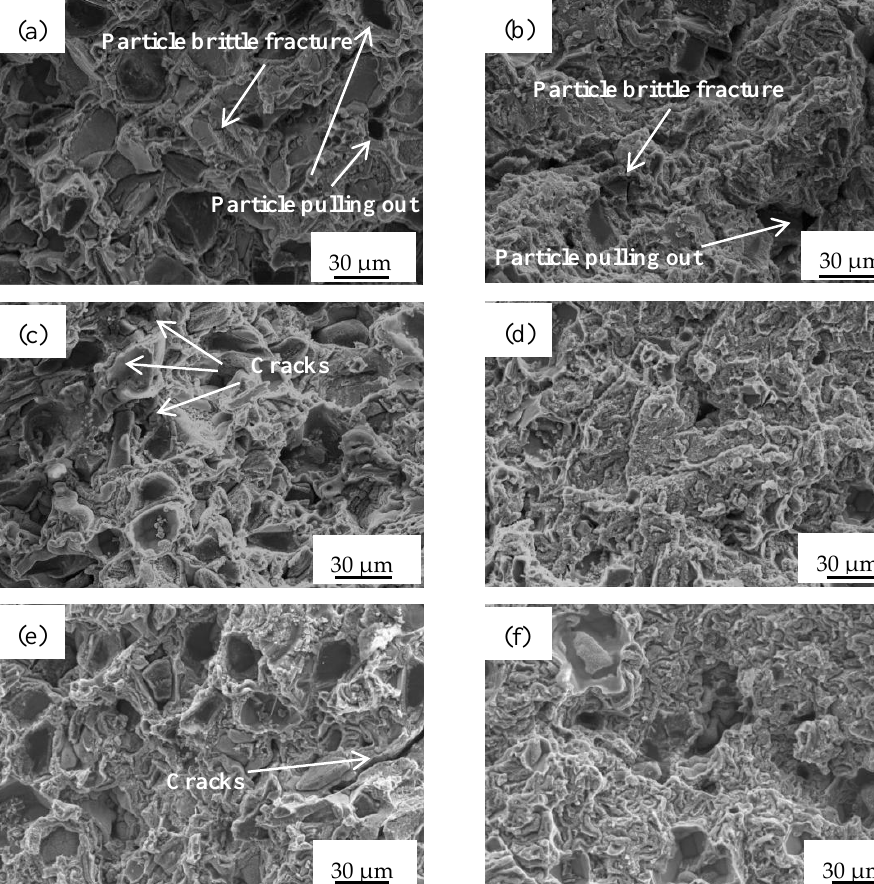
Figure 7. SEM micrographs of bending fracture surfaces of (B 4 C+Ti)/Mg ( a , c , e ) and (B 4 C+Ti)/AZ91D ( b , d , f ) composites prepared for 30min ( a , b ), 90min ( c , d ) and 180min ( e , f